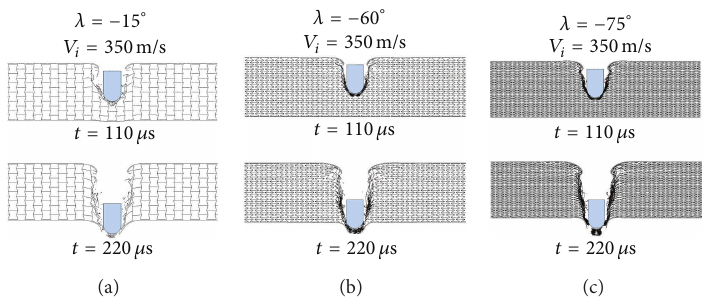
Figure 20: Snapshots of perforation processes of auxetic HPSs with different reentrant unit cell angles by projectiles at 𝑉 𝑖 = 350 m/s: (a) 𝜆 = −15 ∘ , (b) 𝜆 = −60 ∘ , and (c) 𝜆 = −75 ∘ .